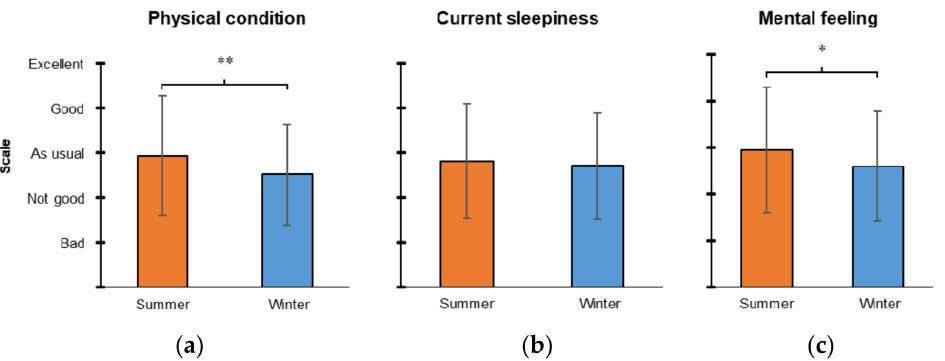
Figure 5. Physical conditions sensation during summer and winter: ( a ) physical condition, ( b ) current sleepiness, and ( c ) mental feeling; Significancy: * p < 0.1, ** p <